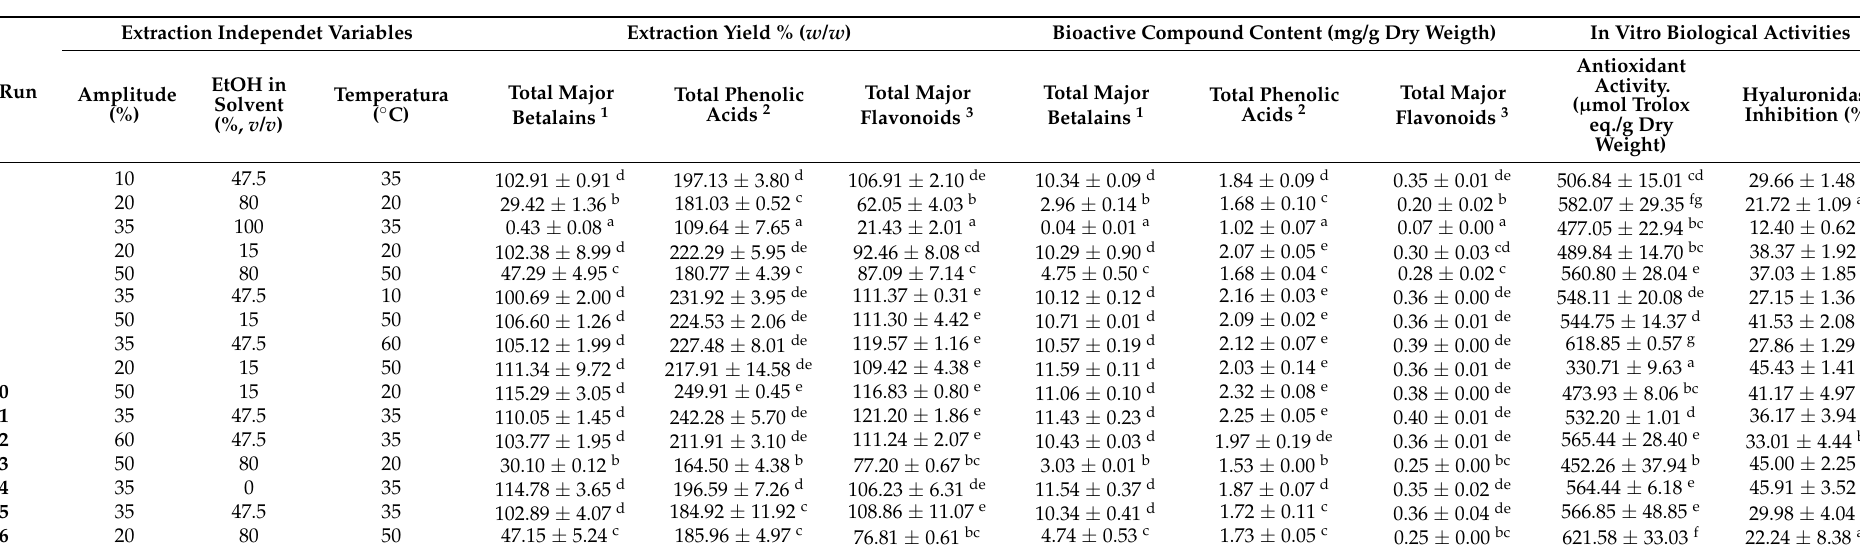
Table 2. UAE Central composite design (CCD) for three independent variables and experimental results of the extraction yield, the content of the most abundant bioactive compounds (total major betalains, total phenolic acids and total major flavonoids) and biological activities (antioxidant and anti-inflammatory) obtained by UAE at 5 min of the central composite design (CCD)